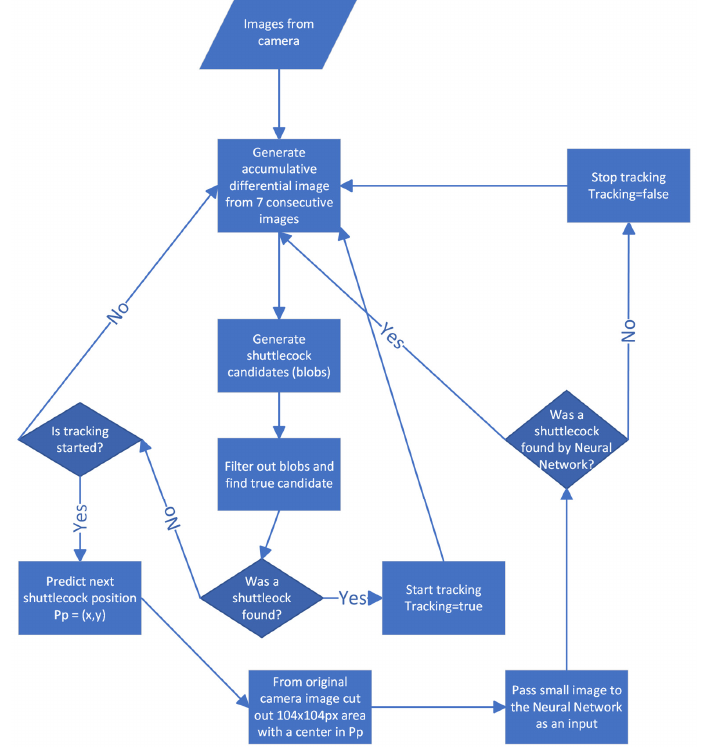
Figure 11. Algorithm structure.